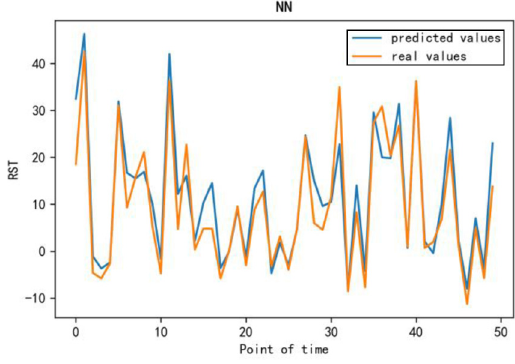
Figure 14. Line chart of real value and predicted value with